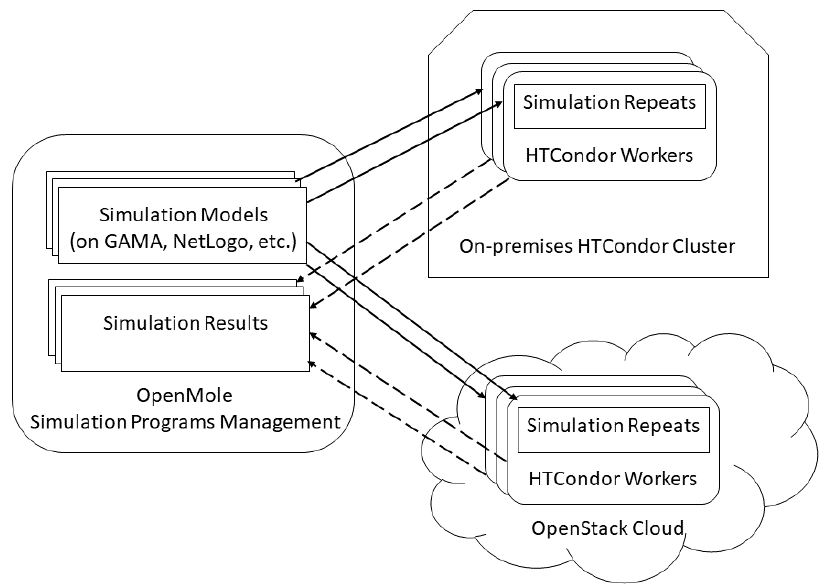
Figure 3. System architecture of proposed framework’s implementation.